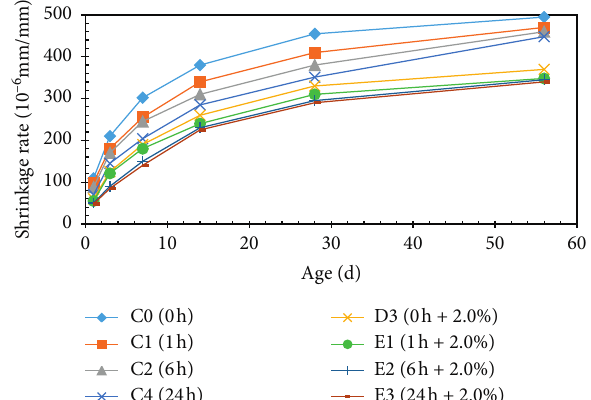
Figure 12: Effect of the prewetting time on concrete shrinkage with SRA incorporation.